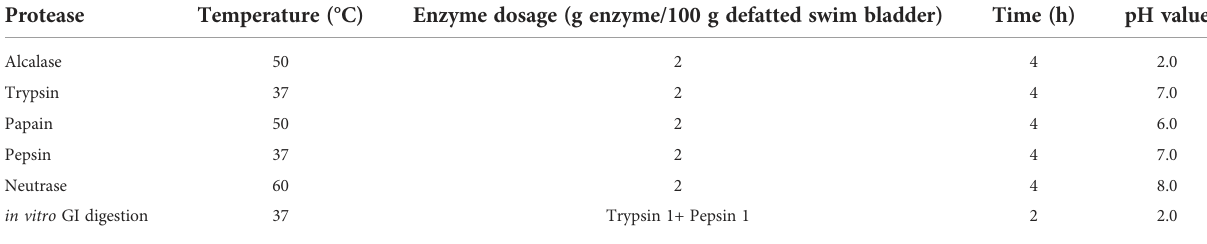
TABLE 1 Hydrolysis parameters of different proteases and in vitro GI digestion method.